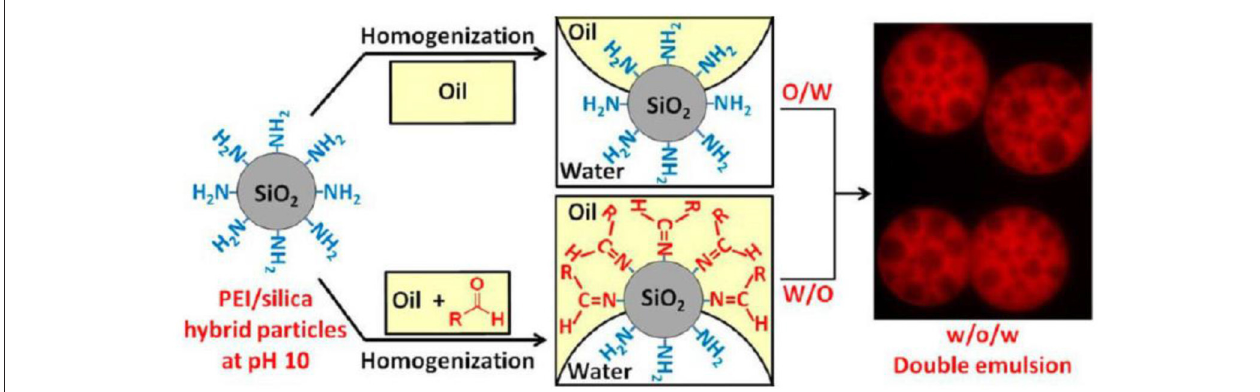
FIGURE 4 | Schematic illustration of the preparation of W/O/W multiple emulsions using hybrid PEI/silica particles with adjustable wettability via Schiff base chemistry (Williams et al., 2014b). Reprinted with permission Williams et al. (2014b). Copyright 2014 American Chemical Society.